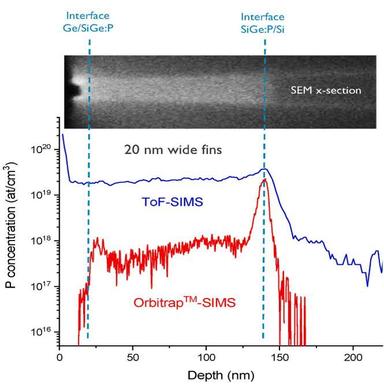
P quantified in 20 nm wide fins using ToF-SIMS (blue curve) and Orbitrap™-SIMS (red curve) and corresponding cross-section SEM. The fluences of the ToF-SIMS and Orbitrap™-SIMS profiles are converted to depth and the profiles are aligned at the interface with the Si substrate for better comparison.